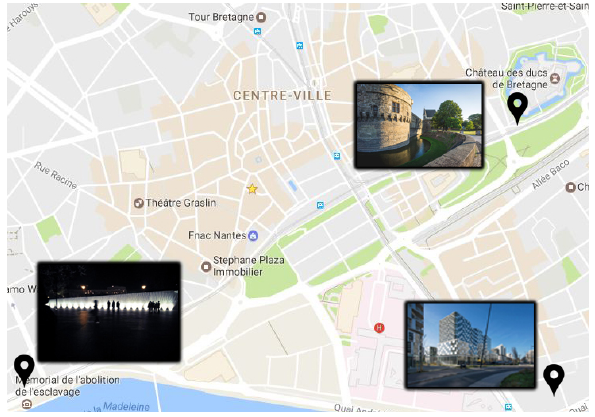
Figure 9. Map showing some images retrieved from flickr.